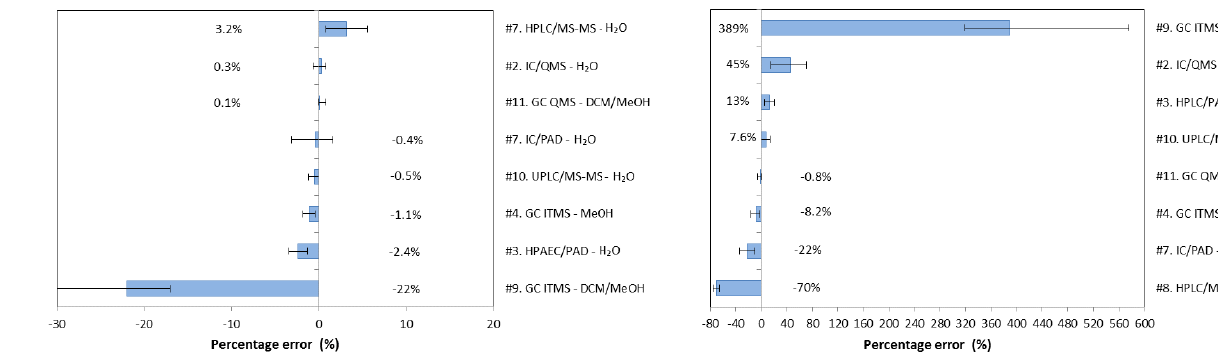
Figure 5. Calculated mean percentage error (PE) for each of the eight laboratories for which the levoglucosan to MA ratio could be derived. The PE was calculated according to Eq. (1) (Sect. 2.5) for each of the six sectors received by the participating laboratories. The mean PE for each laboratory accounts for the PE calculated for all six sectors. The laboratory number, ranging from 1 to 13, the analytical method and solvent used for extraction are mentioned at the right of the figure.